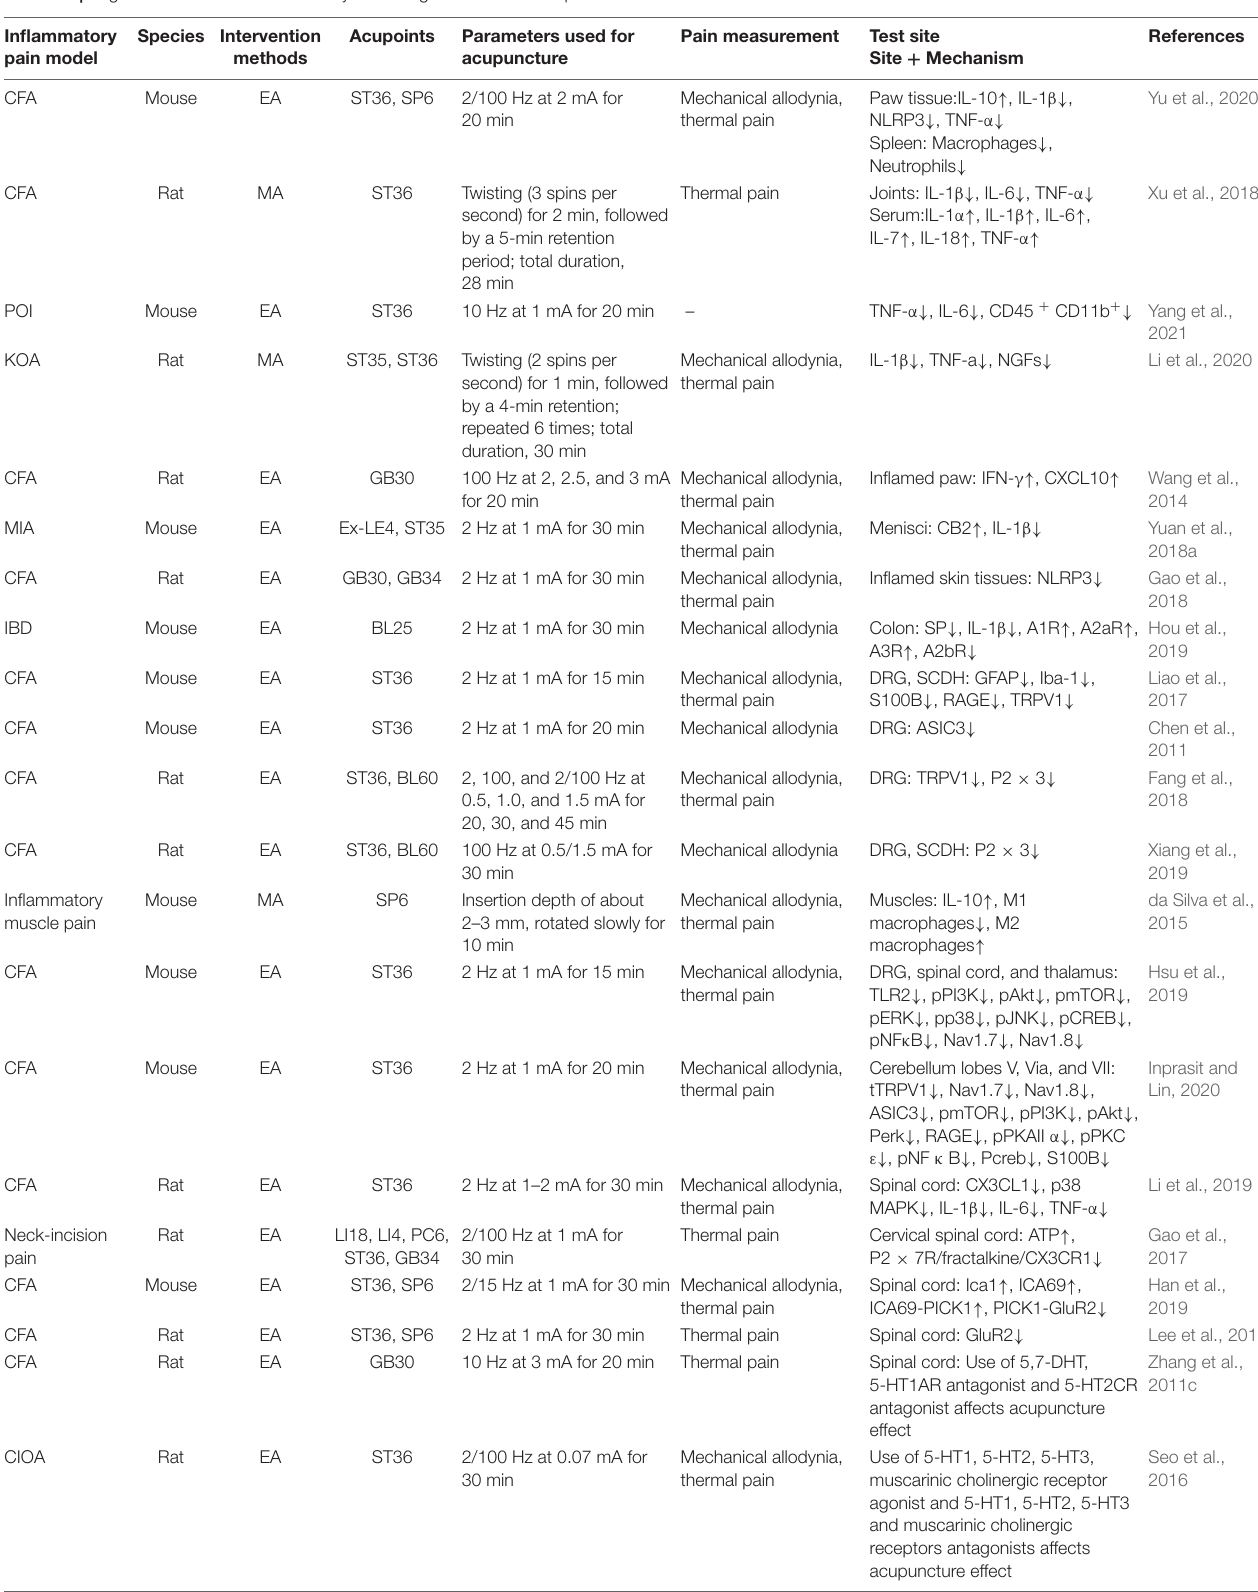
TABLE 1 | Regulation of the anti-inflammatory and analgesic effects of acupuncture. Inflammatory Species Intervention pain model